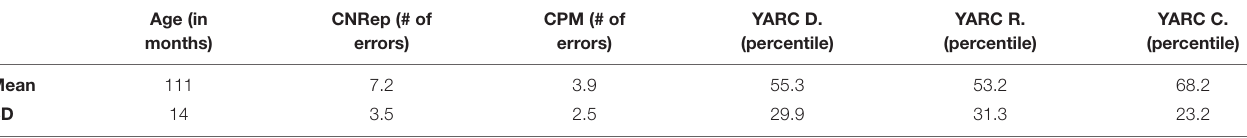
TABLE 1 | Descriptive